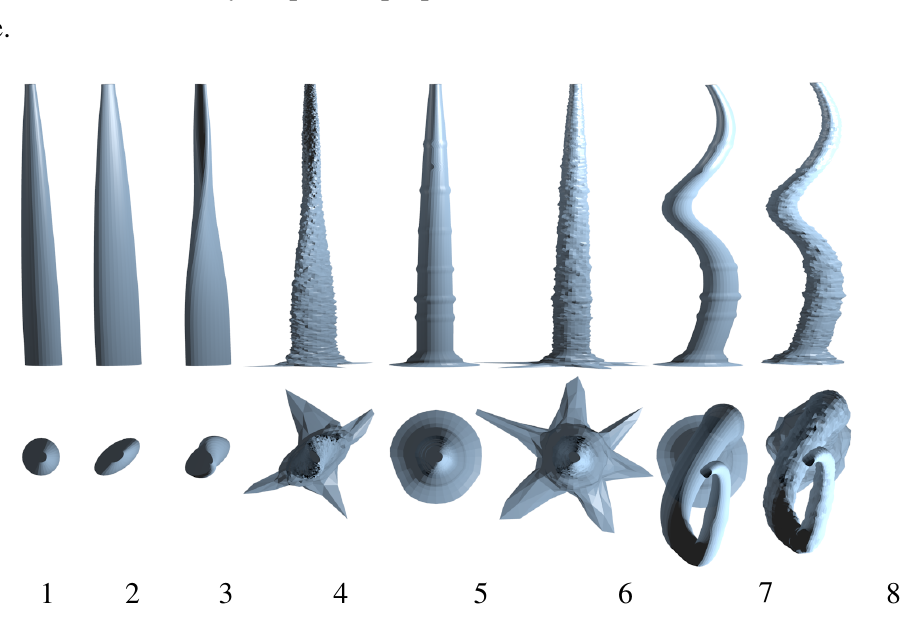
Figure 6. Flattened portraits of generated stem models (vertical dimension scaled down to